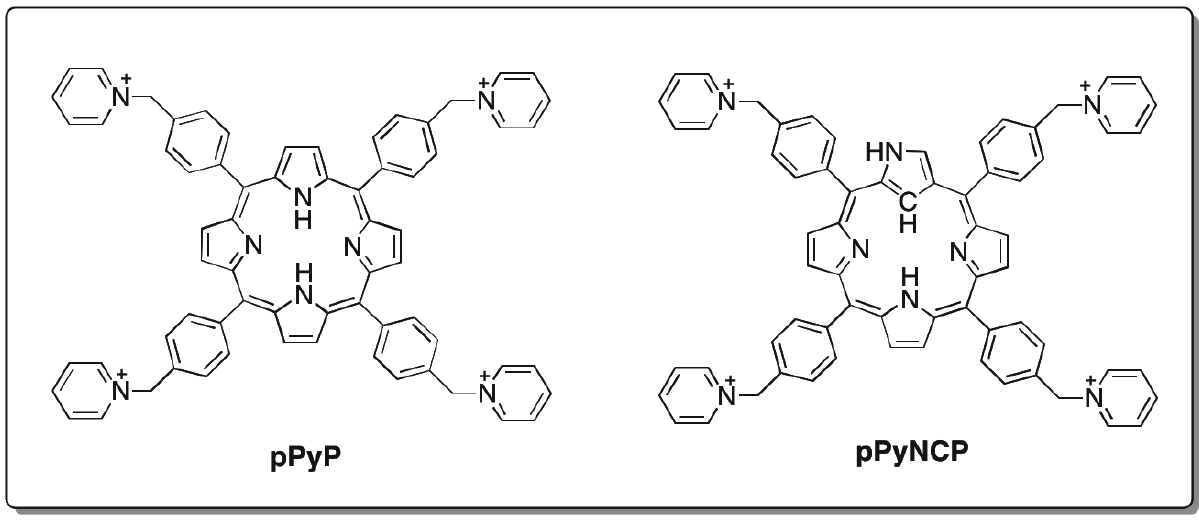
Figure 1. Chemical structures of the cationic porphyrin (pPyP) and the cationic N -confused porphyrin